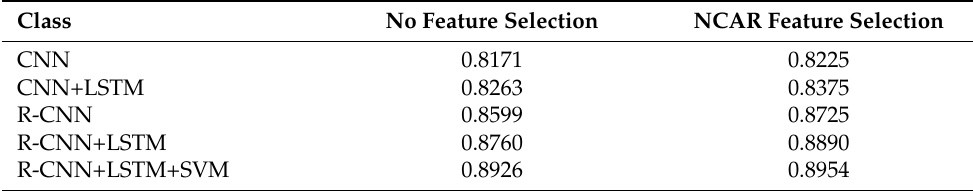
Table 3. The other performance results of the proposed